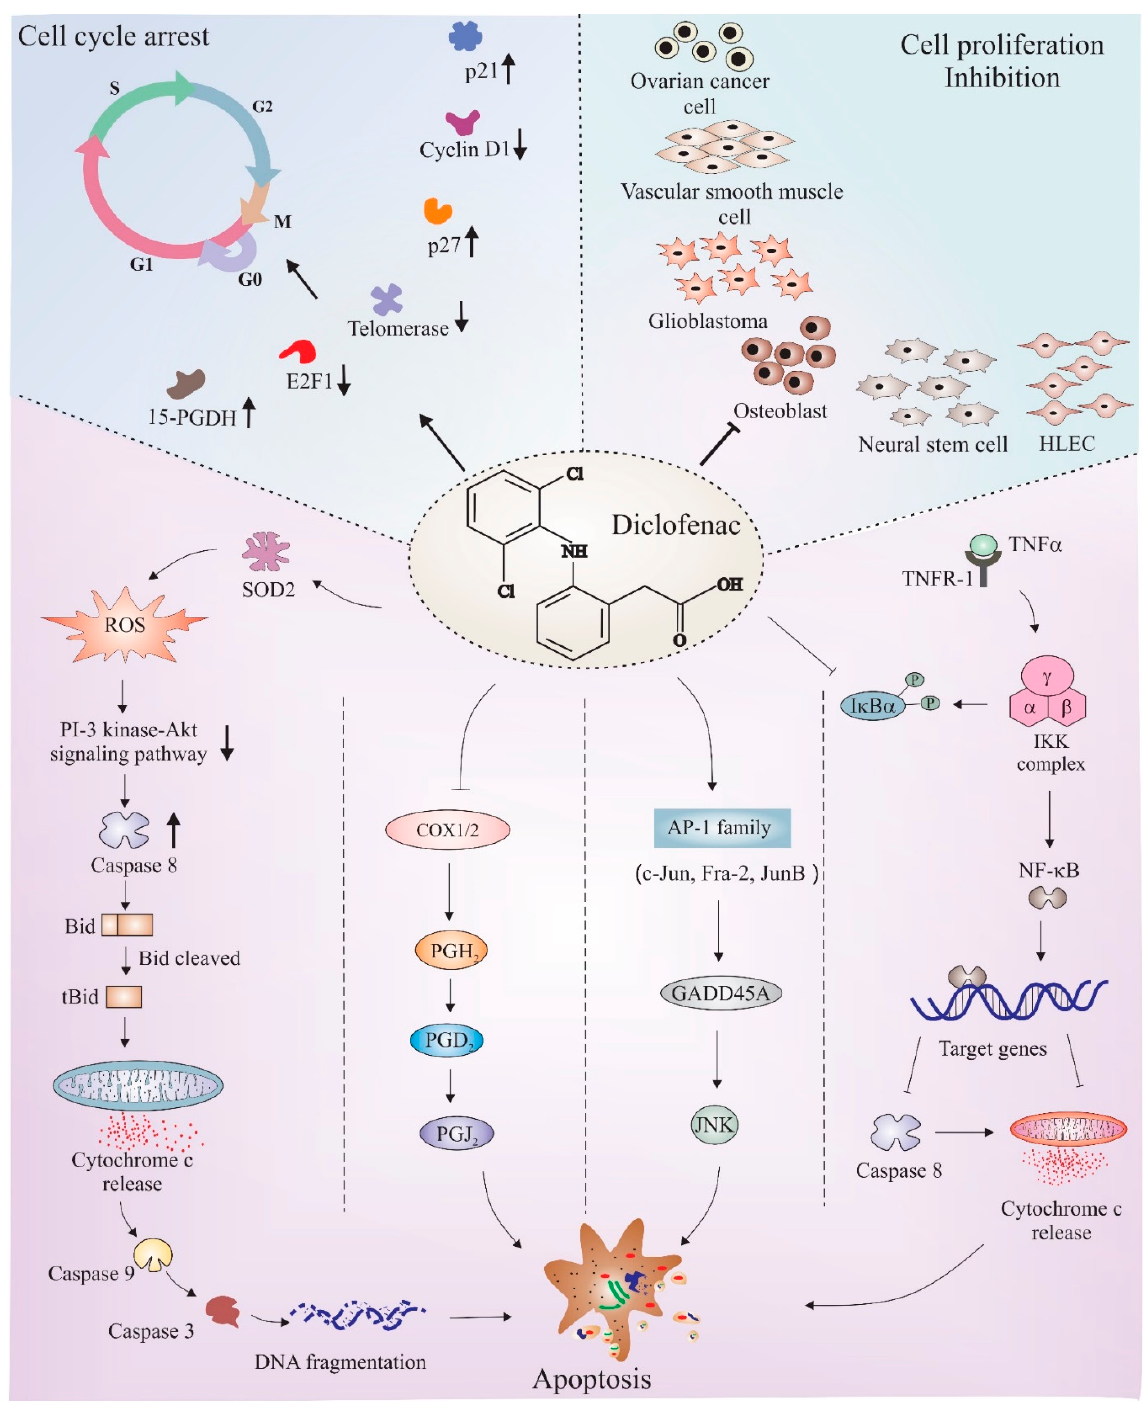
Figure 4. Schematic depiction of mechanisms of diclofenac ‐ mediated apoptosis and cell cycle arrest. Diclofenac is found to obstruct cell cycle in different cell lines, such as neural stem cells, human lymphatic endothelial cells (HLEC), osteoblasts, glioblastomas (GBM), ovarian cells, and VSMC. Studies found an upregulation of cell cycle inhibitory proteins, such as p27, p21, and 15 ‐ hydroxy ‐ prostaglandin dehydrogenase (15 ‐ PGDH), and downregulation of inducers of cell proliferation, such as E2F1 transcription factor and cyclin D1, all crucial factors responsible for causing cell cycle arrest after diclofenac treatment. Diclofenac has also been shown to have pro ‐ apoptotic effects. The major downstream mechanisms that have been thought to be the reason for diclofenac ‐ mediated apoptosis includes ROS ‐ induced downregulation of the PI 3 ‐ kinase/Akt signaling pathway, inhibi ‐ tion of NF ‐ kB activity, disturbance in proteasome activity, interference with COX enzyme activity, and induction of the JNK pathway via AP1 transcription factors. The activation/formation and